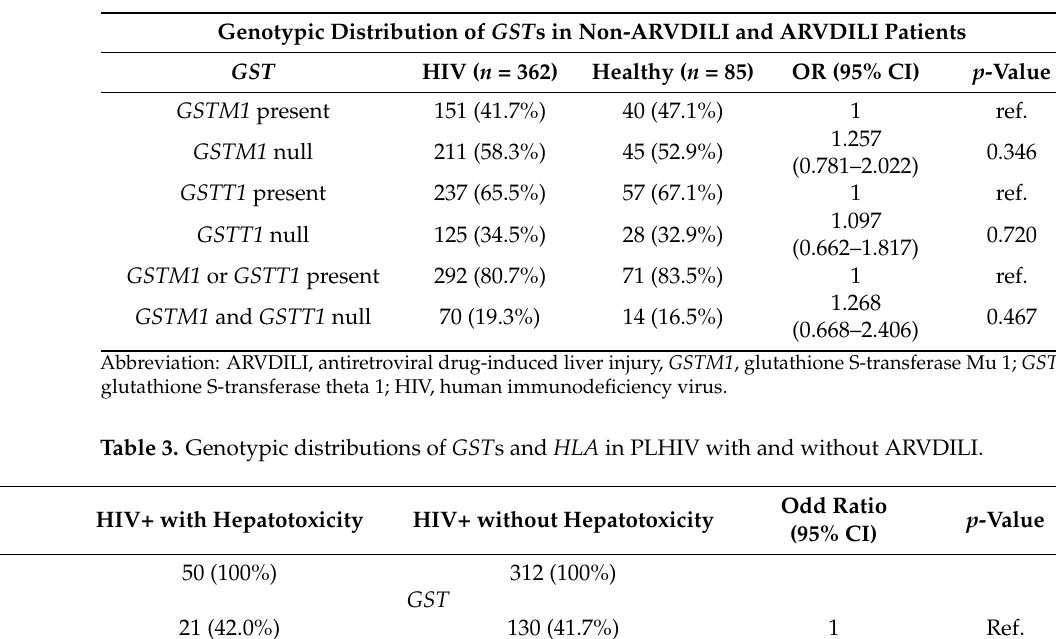
Table 2. Genotypic distributions of GST s in healthy volunteers and PLHIV.